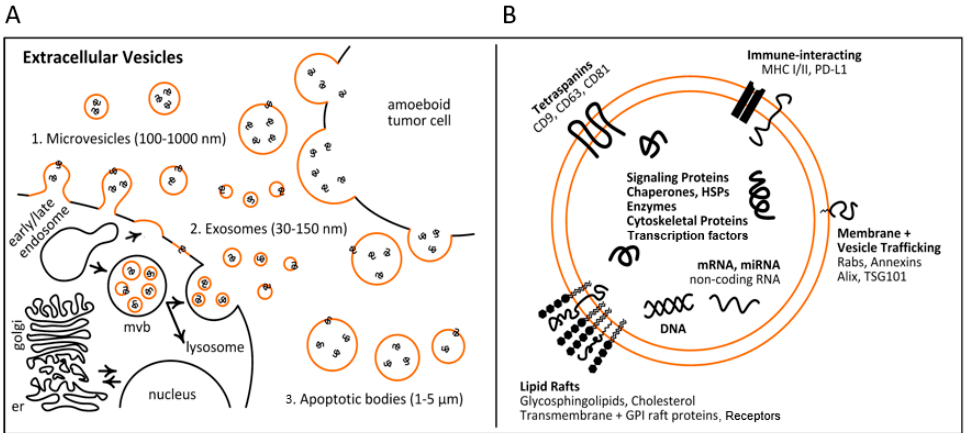
Figure 1. Biogenesis and composition of extracellular vesicles (EVs). ( A ) EVs represent diverse forms of lipid-bound nanoparticles that range from exosomes (30–150 nm) and microvesicles (100–1000 µ m) to apoptotic bodies (1–5 μ m). EV biogenesis starts with early endosomes formed by the invagination of the plasma membrane. Early endosomes either return the cargo as recycling endosomes to the plasma membrane, or transform into multivesicular bodies (MVBs). MVBs are forced to fuse and degrade with lysosomes, or go into the plasma membrane, and intraluminal vesicles are secreted as exosomes. ( B ) Molecular composition of EVs. EVs contain a variety of cellular components, including nucleic acids, signaling proteins, chaperones, HSP proteins, enzymes and transcription factors as cargoes, and lipid rafts, tetraspanins, immune-interacting molecules and vesicle-trafficking proteins as surface proteins.